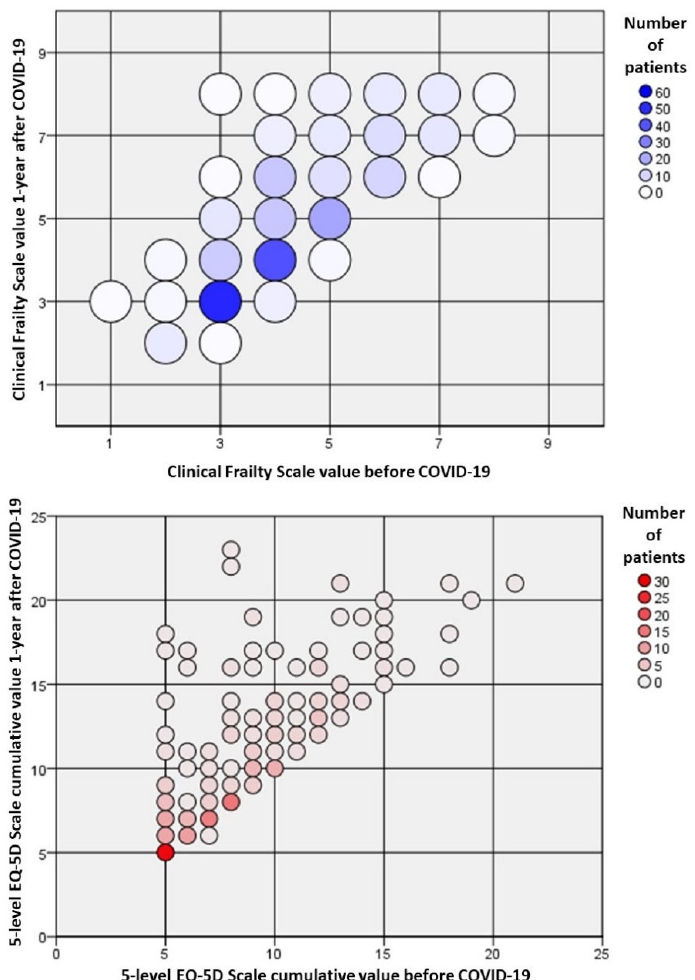
Figure 2. Relative changes in frailty and quality of life of survivors one year after the index hospi- talization for COVID-19. Frailty was measured according to the clinical frailty scale (CFS), and the quality of life was assessed by the cumulative value of the five-level EQ-5D (EQ-5D-5L). Most of the patients had a worsening in frailty and the measured quality of life.